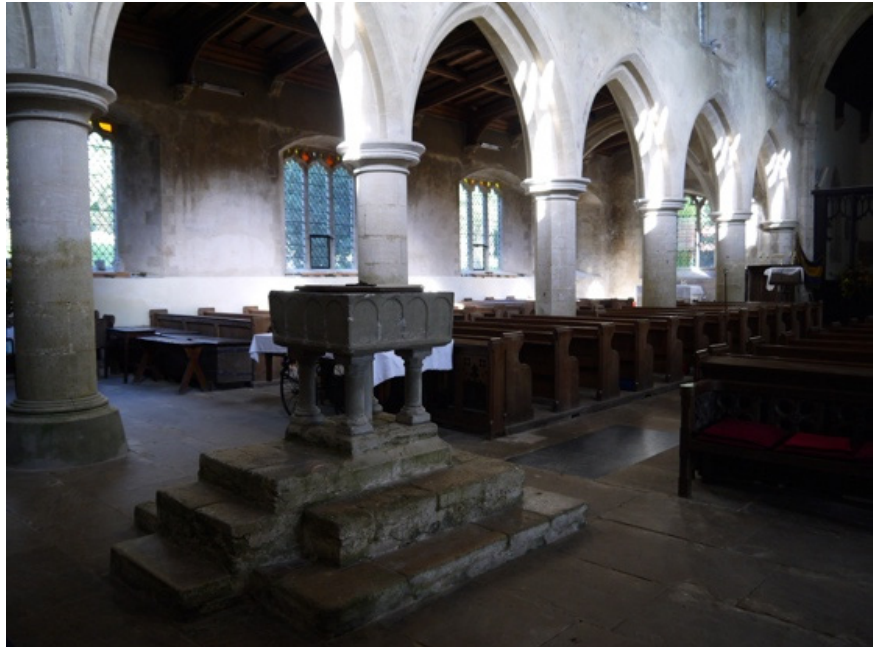
Figure 21. Font with flat lid at St Mary’s Sedgeford.